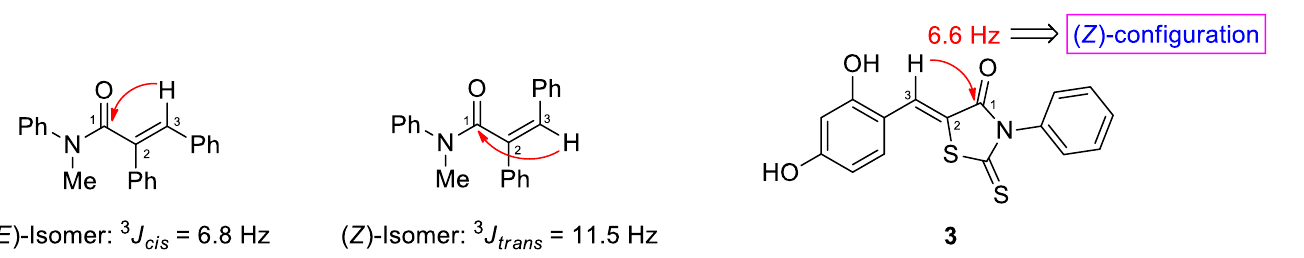
Figure 2. Determination of C, C-double bond geometries using 1 H, 13 C-coupling constants. Arrows indicate H,C-spin-coupling constants over three bonds.